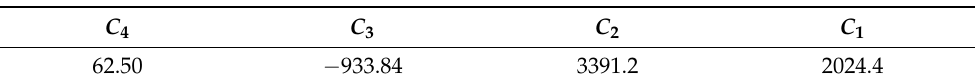
Table 4. Fitting coefficients of g ( Ma